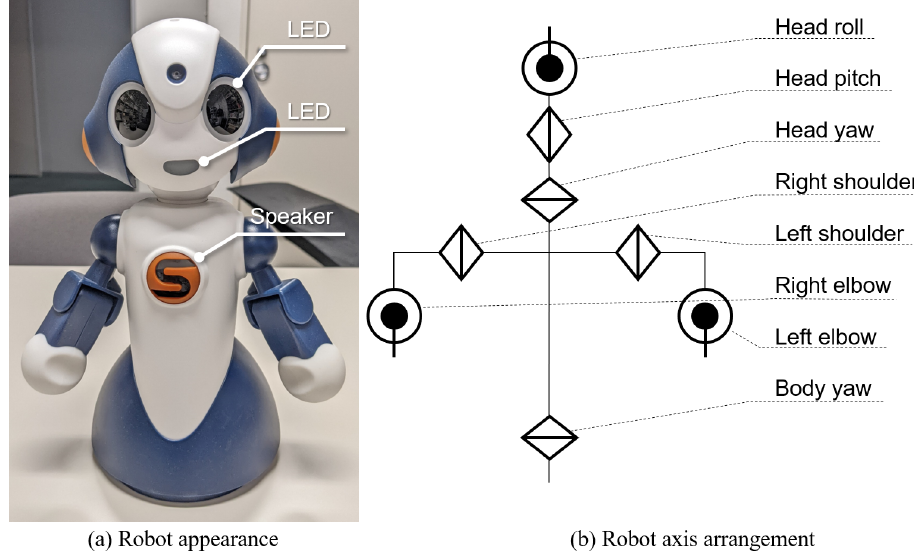
Figure 4. Sota robot and its axis arrangement.